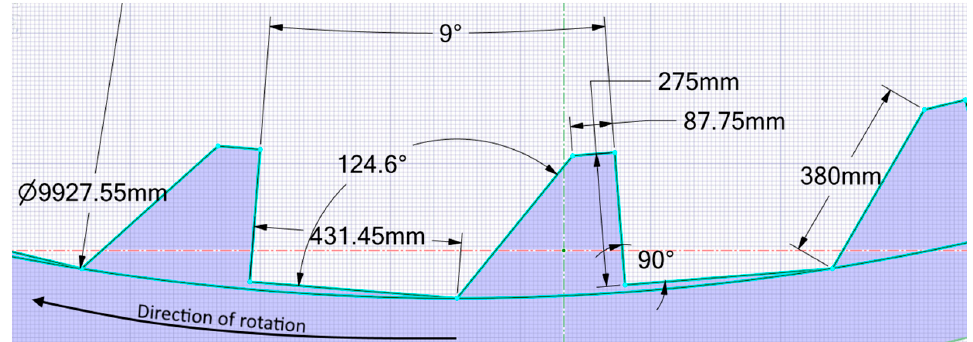
Figure 9. Section of the lining of the cylindrical part of the drum used in the simulation. Table 3. Initial data for modeling.